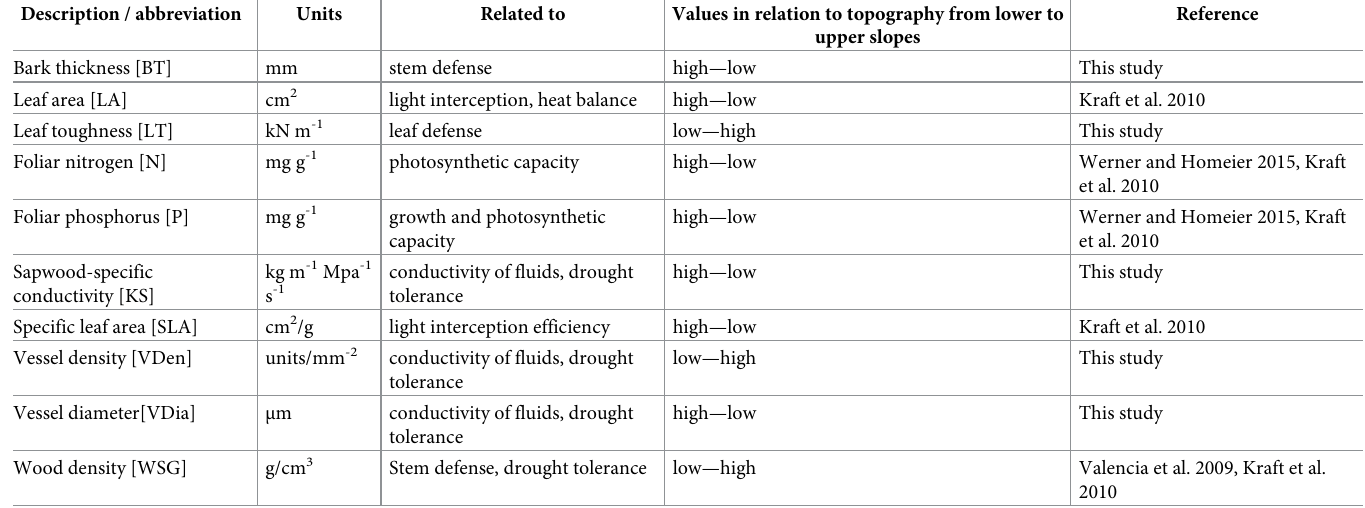
Table 1. Functional traits used in this study, their relation to plant performance after van der Sande et al 2016 [47], and trends of variation along topographic gradi- ents reported in the literature or in this study for tropical forests. Description / abbreviation